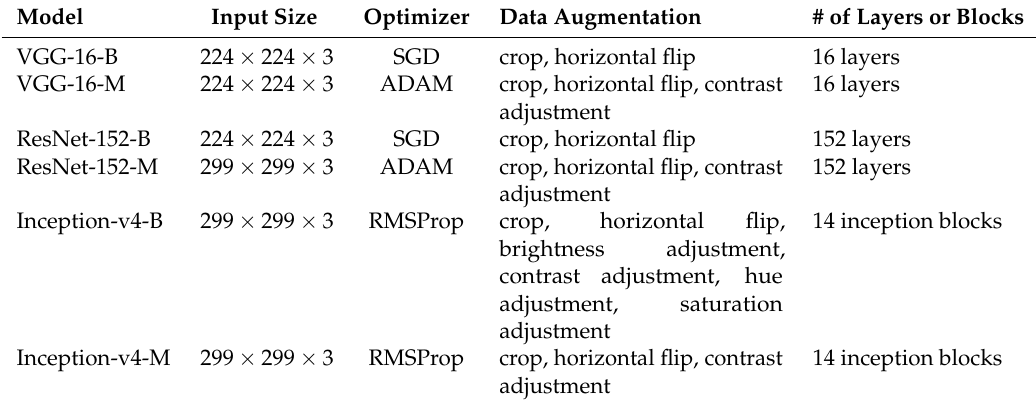
Overview of the different model configurations for VGG-16 [38], ResNet-152 [39], and Inception-v4 [31]. When the name of a model contains the label “B”, this means that the model adopted the settings from the paper that introduced the model in question. When the label “M” has been added to the name of a model, this means that our research context has been taken into account, resulting in the modification of settings, the addition of regularizers such as data augmentation